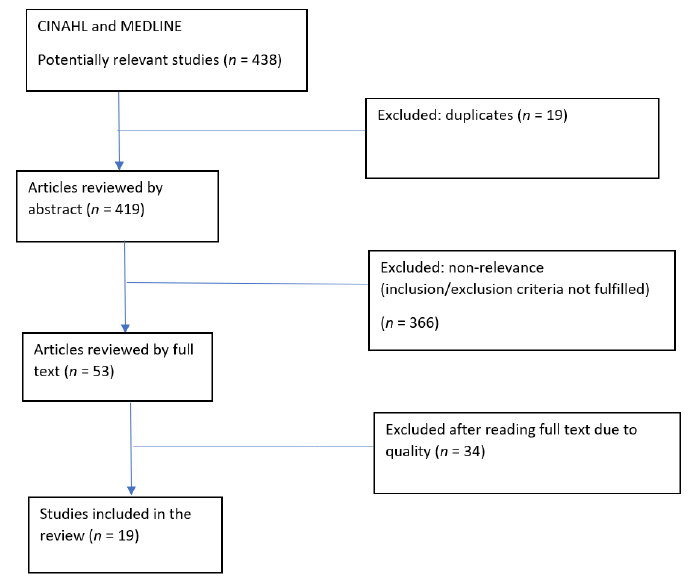
Figure 1. Search process flow chart.